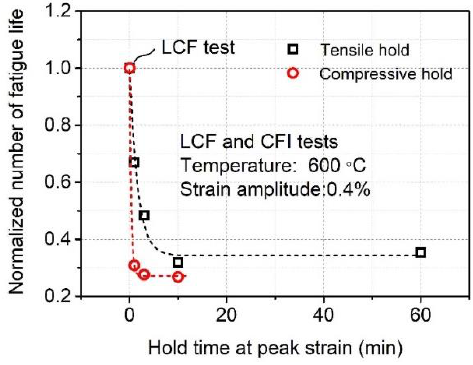
Figure 4. Effects of hold time and hold direction on the fatigue life.